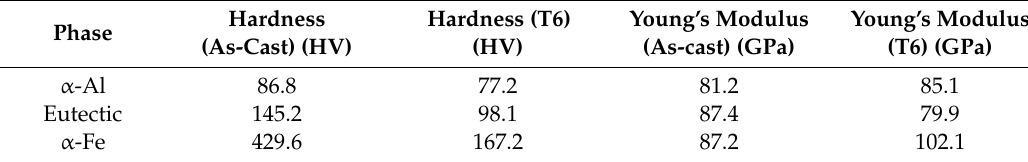
Figure 3. Load-displacement curves of nano-indentation testing of as-cast and T6 AlSiMgMn alloys. Table 2. Hardness and Young’s modulus in di ff erent